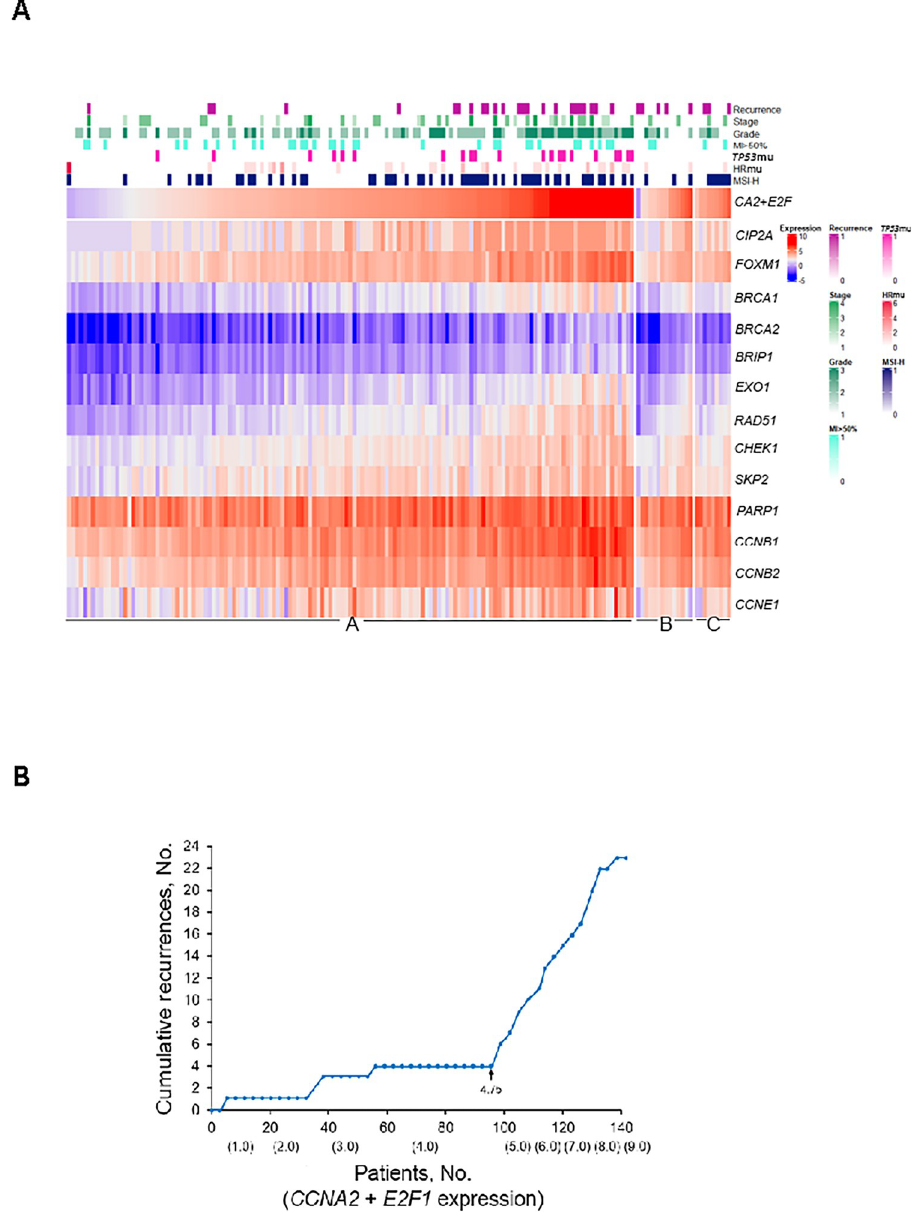
Fig 2. Gene expression and treatment failures. A, The heat map shows distribution of recurrences, stage, myometrial invasion (MI) > 50%, mutation (-mu) in TP53 ( TP53 mu), homologous recombination repair mutations (HRmu), and high microsatellite instability (MSI-H), according to the increasing quantitative sum of CCNA2 and E2F1 log 2 mRNA expression ( CA2 + E2F ). CIP2A , FOXM1 , SKP2 , PARP1 , and HR and cell cycle gene mRNA expression levels also are shown as a function of increasing expression of CA2 + E2F . Group A was defined as the CA2 + E2F cohort minus PPP2R1A mu and FBXW7 mu cohorts (n = 141); group B was the PPP2R1A mu cohort (n = 14), and group C was the FBXW7 mu cohort (n = 9). Patients with POLE mu were excluded from this analysis. B, Cumulative recurrences are shown as a function of the expression sum of CCNA2 and E2F1 ( CA2 + E2F ). � 50% MI). Seven patients (25%) had documented recurrences, and 6 of these recurrences occurred among the 9 patients in this group with MHR. ECPPF status of patients with early- stage, low-risk CTNNB1 mu was associated with differences in survival ( P < .001) (Fig 3C).